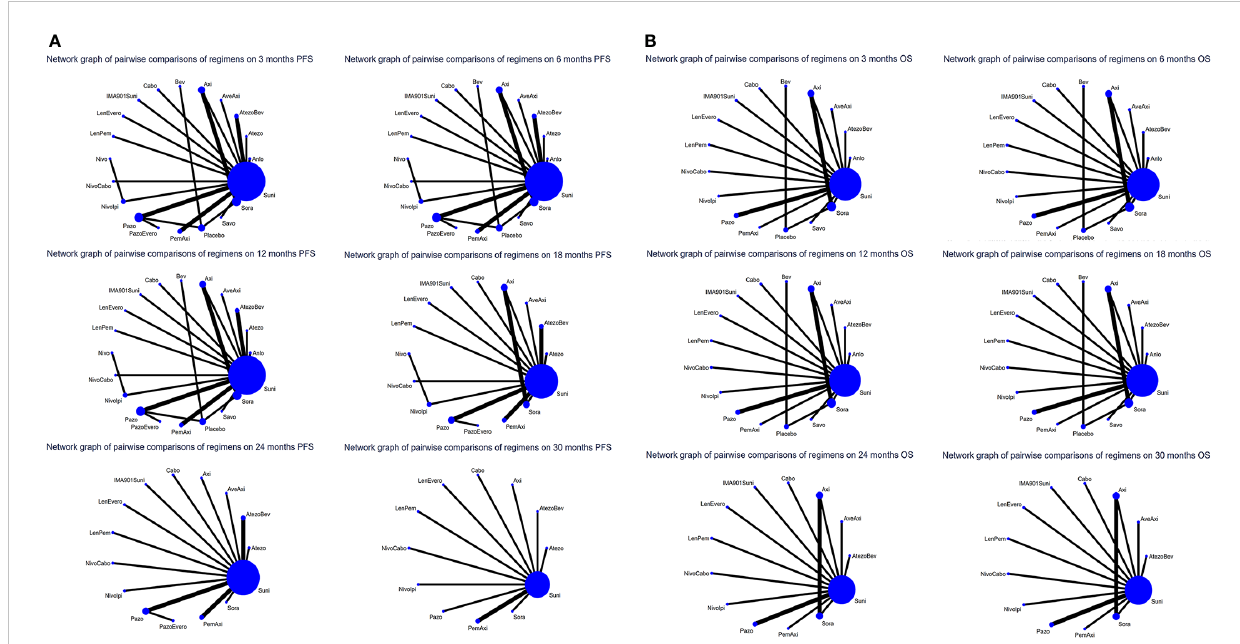
FIGURE 2 (A) Network graphs of pairwise comparison of regimens on each time point of the progression free survival and (B) Network graphs of pairwise comparison of regimens on each time point of the overall survival. PFS, progression free survival; OS, overall survival; Suni, Sunitinib; Bev, Bevacizumab; Cabo, Cabozantinib; Pazo, Pazopanib; Savo, Savolitinib; Sora, Sorafenib; Axi, Axitinib; Anlo, Anlotinib; Nivo, Nivolumab; Atezo, Atezolizumab; PemAxi, Pembrolizumab plus Axitinib; AtezoBev, Atezolizumab plus Bevacizumab; AveAxi, Avelumab plus Axitinib; LenPem, Lenvatinib plus Pembrolizumab; NivoCabo, Nivolumab plus Cabozantinib; NivoIpi, Nivolumab plus lpilimumab; LenEvero, Lenvatinib plus Everolimus; PazoEvero, Pazopanib plus Everolimus; IMA901Suni, IMA901 plus